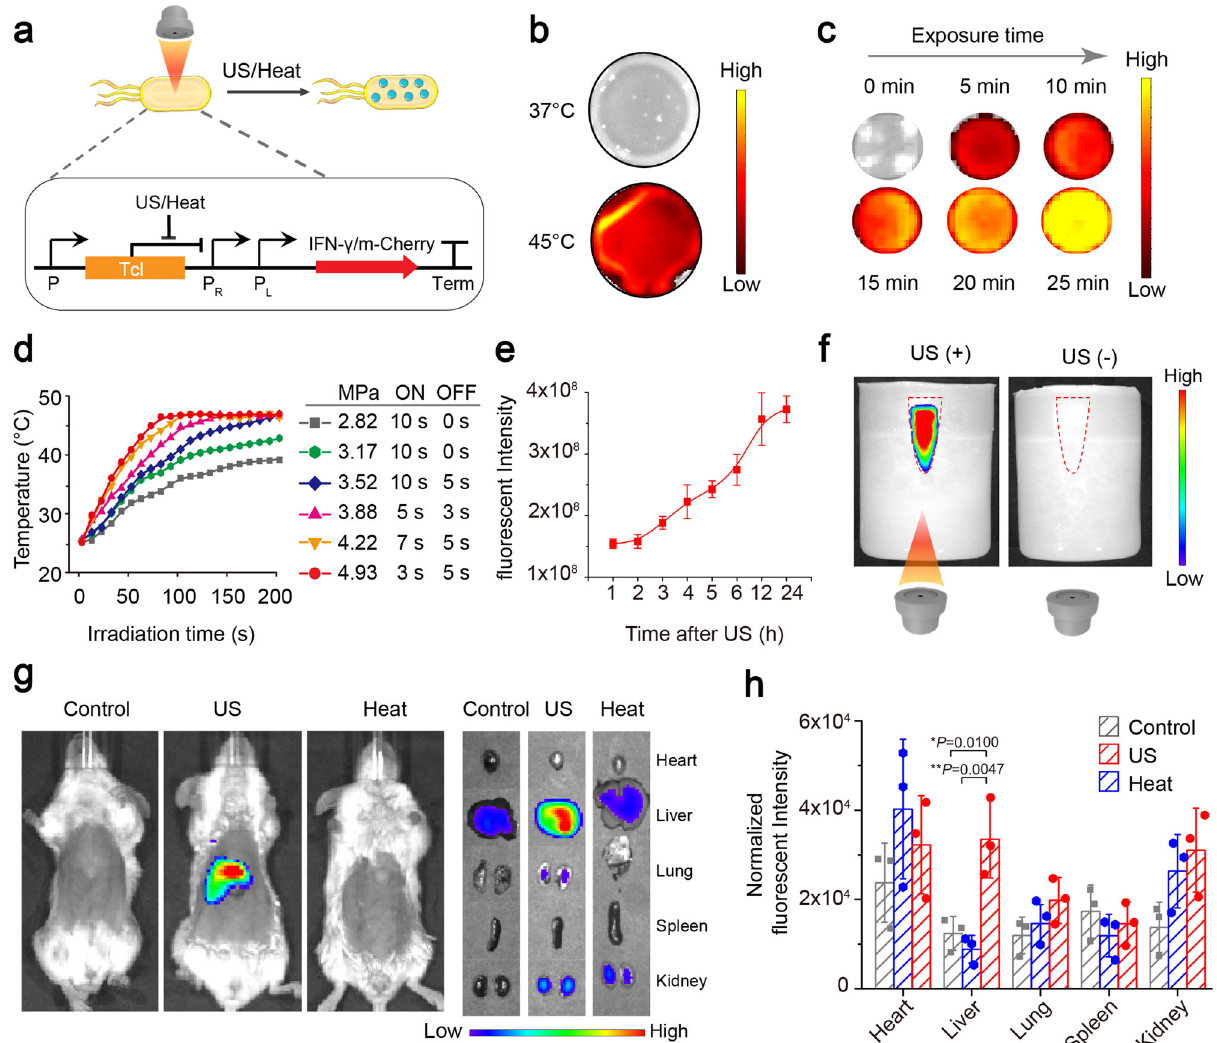
Fig. 2 The gene expression of URB trigged by hyperthermia and ultrasound. a Mechanism of mCherry/IFN- γ expression based on pBV220 plasmid in the bacteria. b Fluorescence image of mCherry protein in URB under different temperature. Images were representative of three experiments. c Fluorescence image of mCherry protein in URB under 45 °C with different time. Images were representative of three experiments. d Quanti fi cation of temperature of bacteria solution irradiated with the different acoustic pressures by focused ultrasound. Experiments were performed three times independently with similar results. e Quanti fi cation of fl uorescence signals of bacteria solution after ultrasound irradiation. n = 3 biologically independent samples at each time point. Data were presented as mean ± S.D. f Fluorescence image of mCherry protein of URB in the center of the gel phantom under ultrasound irradiation. Images were representative of three experiments. g Fluorescence image of mice injected with 1 × 10 7 CFU of URB under liver-targeted ultrasound irradiation. Images were representative of three experiments. h Quanti fi cation of fl uorescence signals of major organs of mice injected with 1 × 10 7 CFU of URB under liver-targeted ultrasound irradiation. The fl uorescent intensity was normalized by organ size. n = 3 biologically independent samples per group. Data were presented as mean ± S.D. Statistical analysis was calculated by using one-way analysis of variance with a Tukey ’ s test (**** P < 0.0001; *** P < 0.001; ** P < 0.01; * P < 0.05;). Source data are provided as a Source Data fi dead cells. With the increase of IFN- γ proteins, the proportion of living cells (green fl uorescence) decreased gradually, while the proportion of dead cells (red fl uorescence) increased gradually (Fig. 3d).